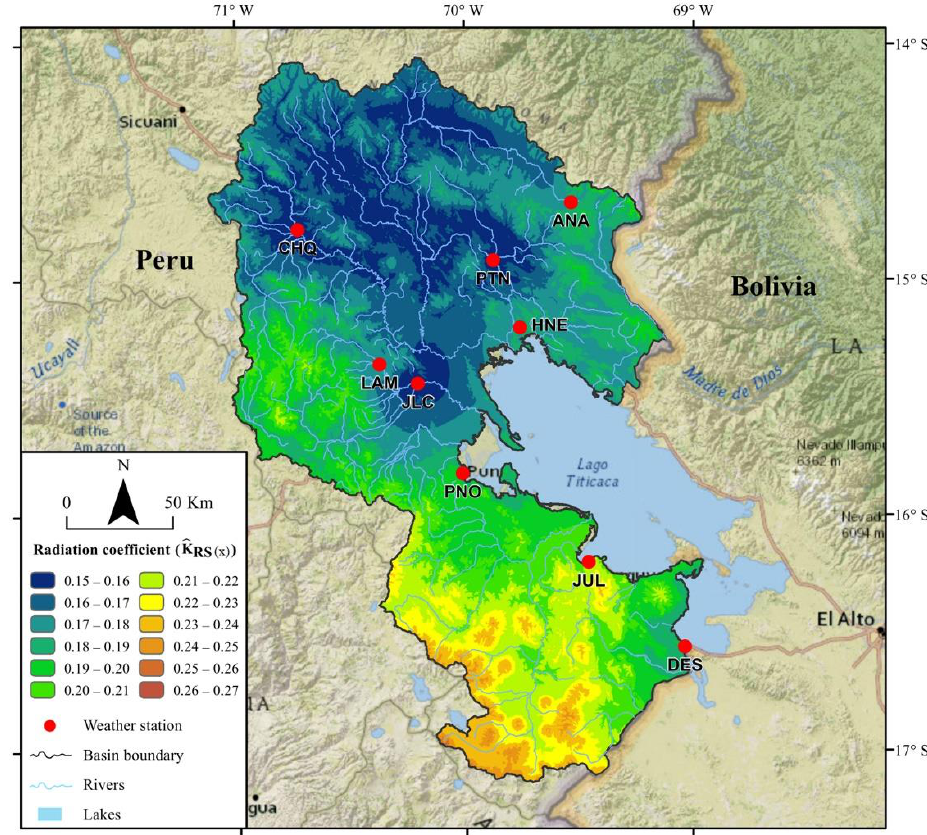
Figure 7. Spatial distribution of the radiation coefficient 𝐾̂ 𝑅𝑆(𝑥) .